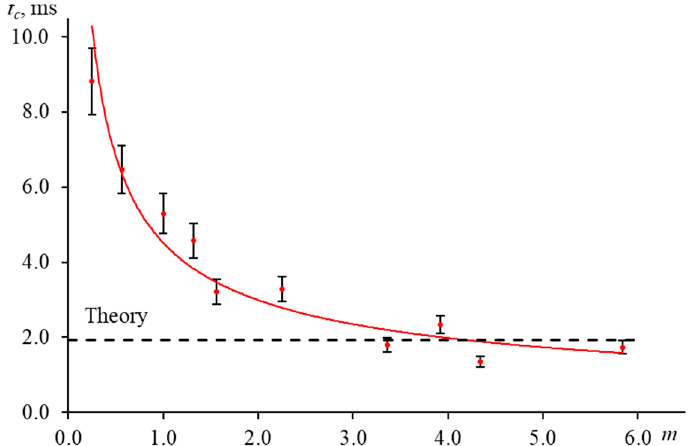
Figure 21. Behavior of the characteristic time for an aqueous solution of ferroin (2.5 µmol/L) with increasing mode-mismatch factor m ; narrow-focused configuration ( 𝜔 (cid:3032)(cid:2868) = 33 µm, Figure 1, Table